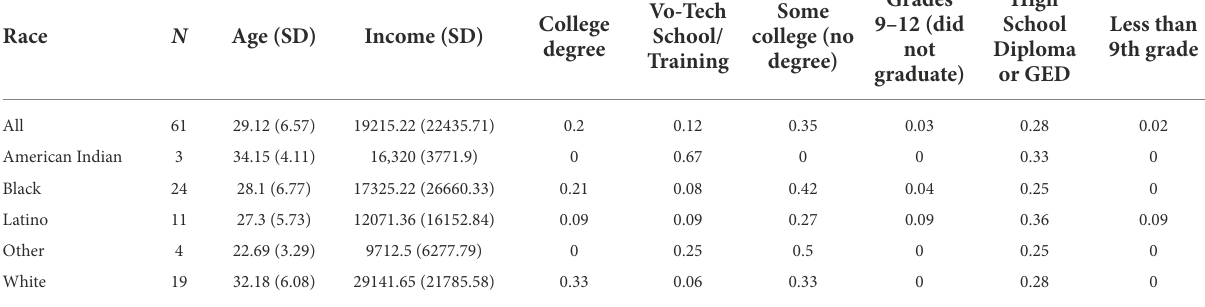
TABLE 3 Demographic variables for empirical